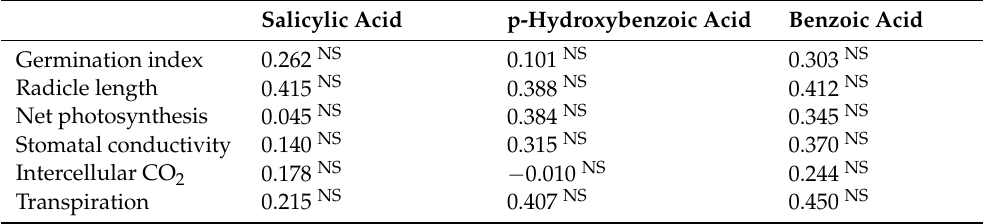
Table 5. Correlation between the three metabolites detected in all four selected strains and various parameters. The germination index and radicle length taken were for seeds treated with microalgae biomass at 1 g L − 1 concentration. NS represents significant differences from the control at p <